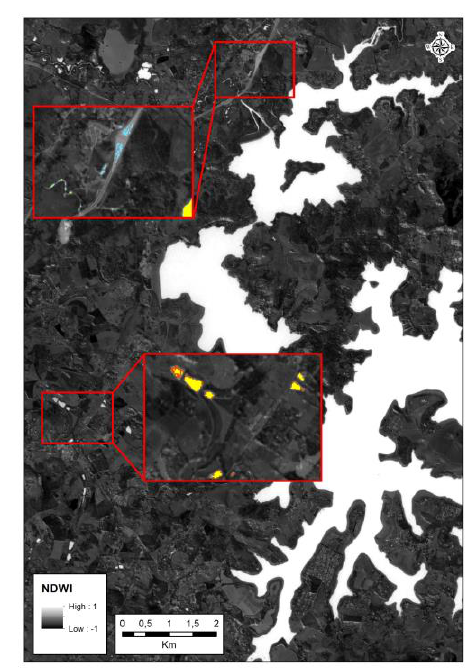
Figure 2 – Example of Spectral Modelling: NDWI and